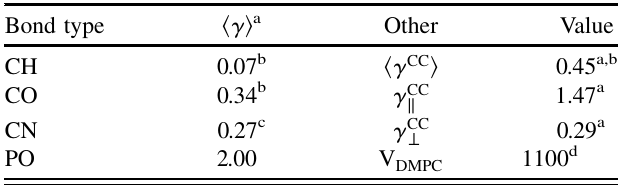
TABLE I. Values used to compute (cid:1) DMPC , (cid:3) ð 3 Þ ML . Bond